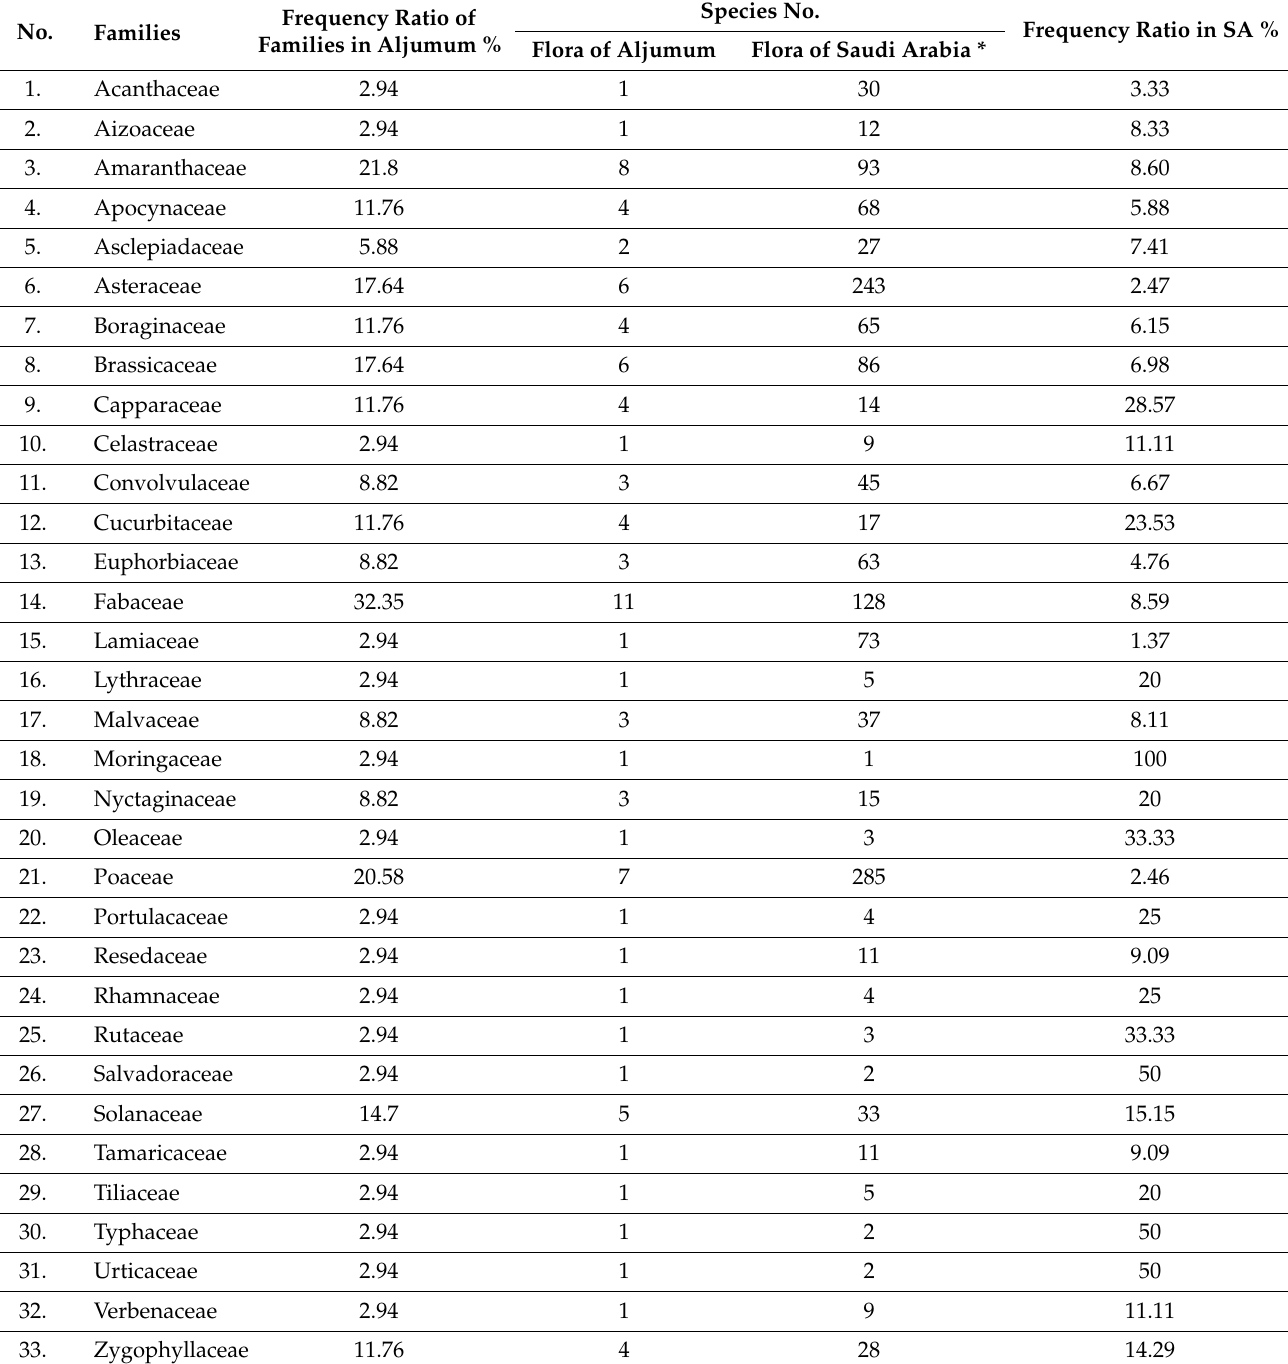
Table 2. Comparison of species’ percentages for each family in the flora of Aljumum and species diversity in Saudi Arabia. Species No. Frequency Ratio of Frequency Ratio in SA % No. Families Families in Aljumum % Flora of Aljumum Flora of Saudi Arabia